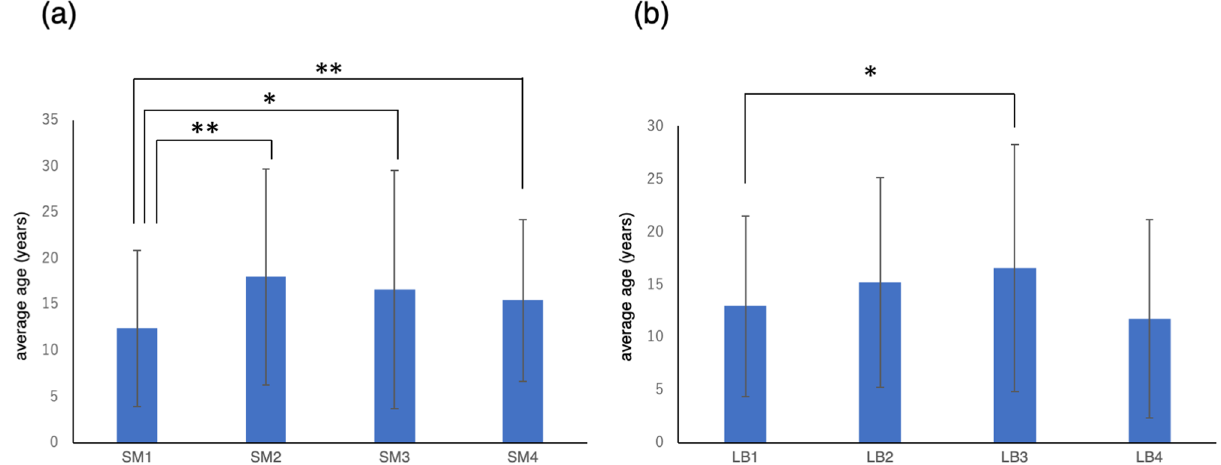
Figure 3. Evaluation of bacterial score and the average age. Comparison of the average age among the score of ( a ) Streptococcus mutans and ( b ) Lactobacillus spp. using the Kruskal–Wallis test. Significant differences are indicated as * p < 0.05, ** p < 0.01 and *** p <